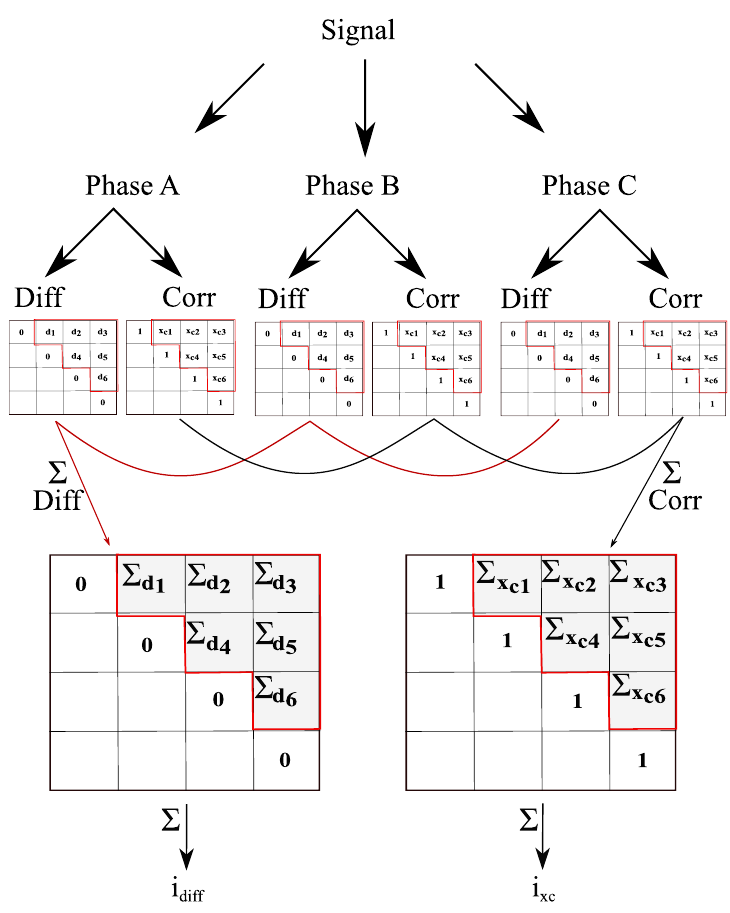
Figure 7. Indicators computation process